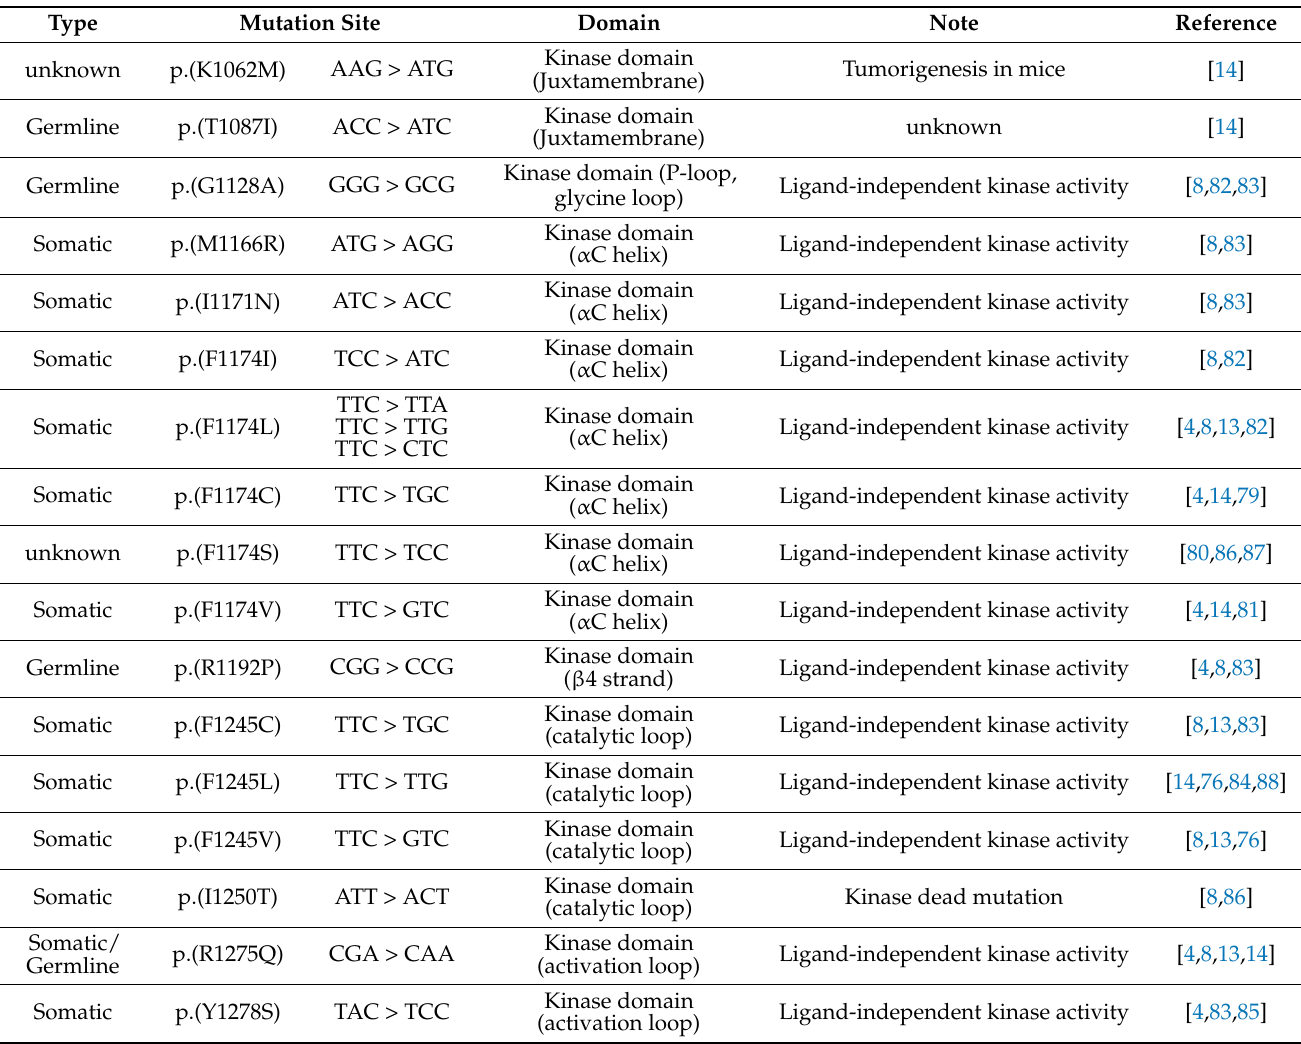
Table 2. ALK point mutations described in